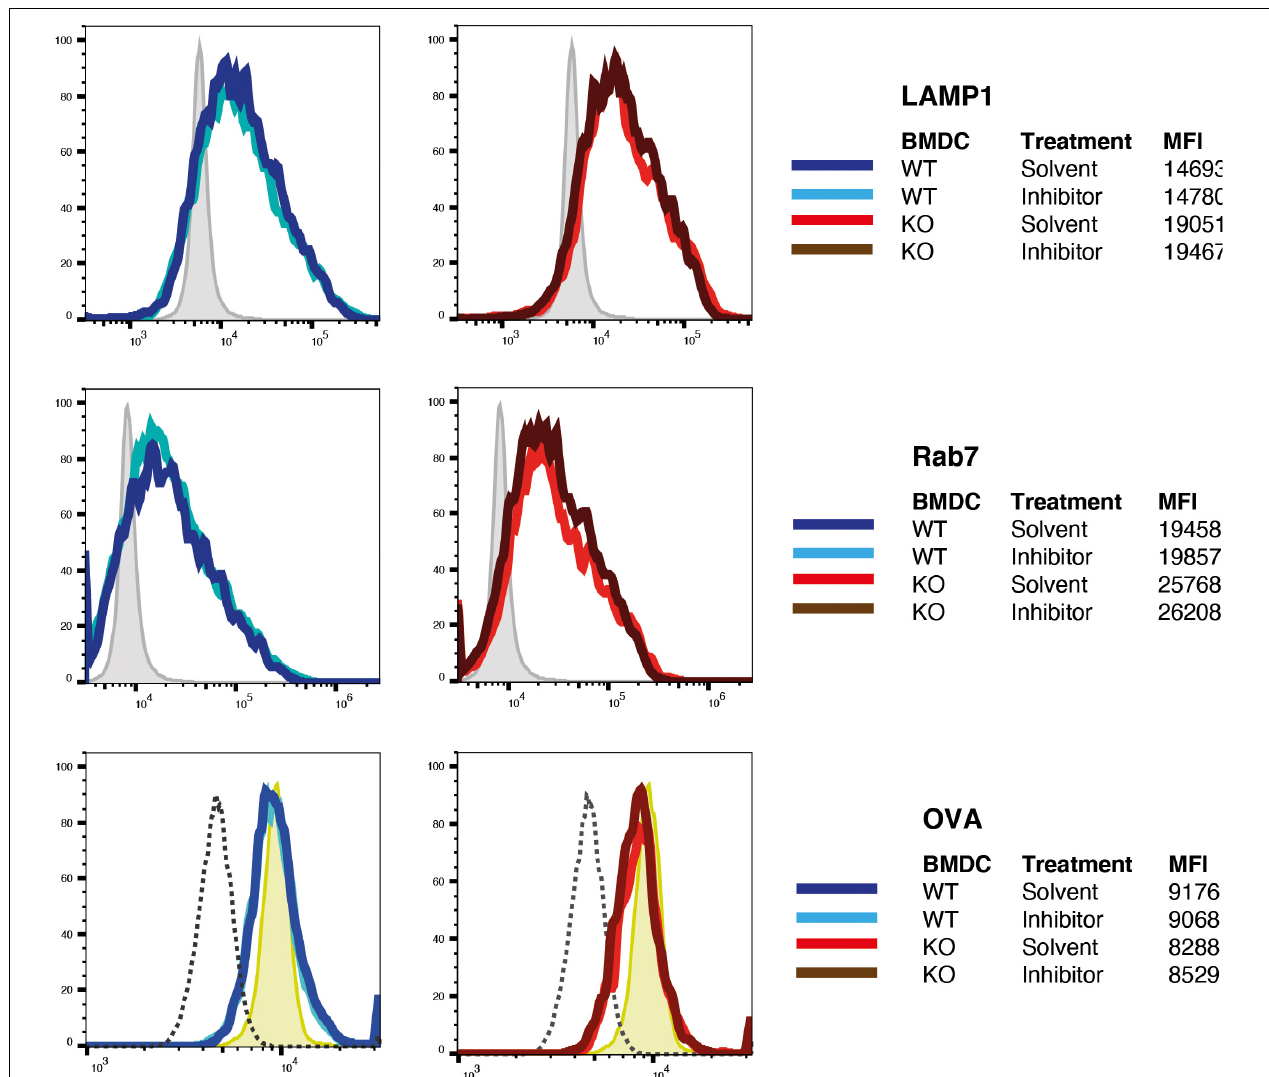
FIGURE 4 | Inhibition of insulin-regulated aminopeptidase (IRAP) protease activity does not alter phagosome maturation. Latex beads covalently coupled to ovalbumin (OVA) were fed to bone marrow-derived dendritic cells (BM-DCs) preincubated with the IRAP inhibitor DG-026A or solvent were incubated for 10 min with OVA-coated latex beads, washed, incubated in the presence of DG-026A for another 10 min at 37 ◦ C, and then lysed mechanically for preparation of phagosomes. Fixed phagosomes were stained for the late endosome markers Lamp1 and Rab7 and for OVA and analyzed by flow cytometry. One out of three experiments each performed in duplicate is shown. MFI, mean fluorescence